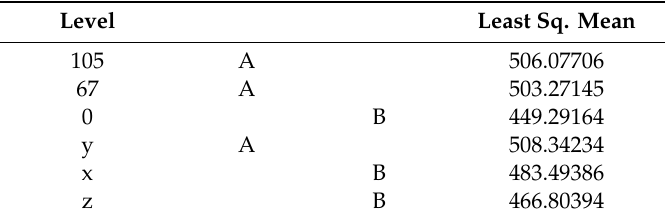
Table 11. Least square means (LS Means) Di ff erences Tukey honestly significant di ff erence (HSD) (yield strength); α = 0.050.